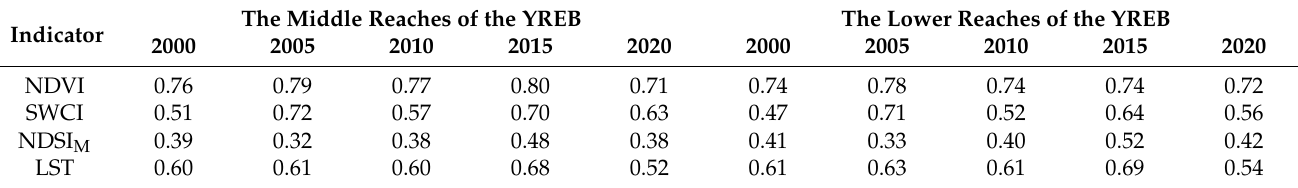
Table 3. Mean values of four normalized indicators of RSEI in the middle and lower reaches of the